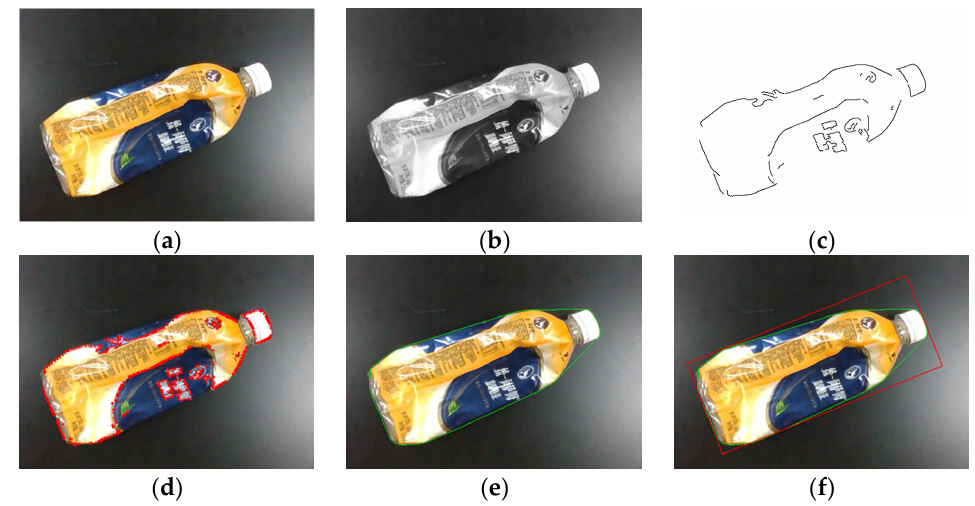
Figure 13. The process of calculating the angle: ( a ) the cropped image; ( b ) gray scale; ( c ) canny edge extraction; ( d ) extraction of contour points; ( e ) calculation of convex hull; ( f ) minimum bounding rectangle.